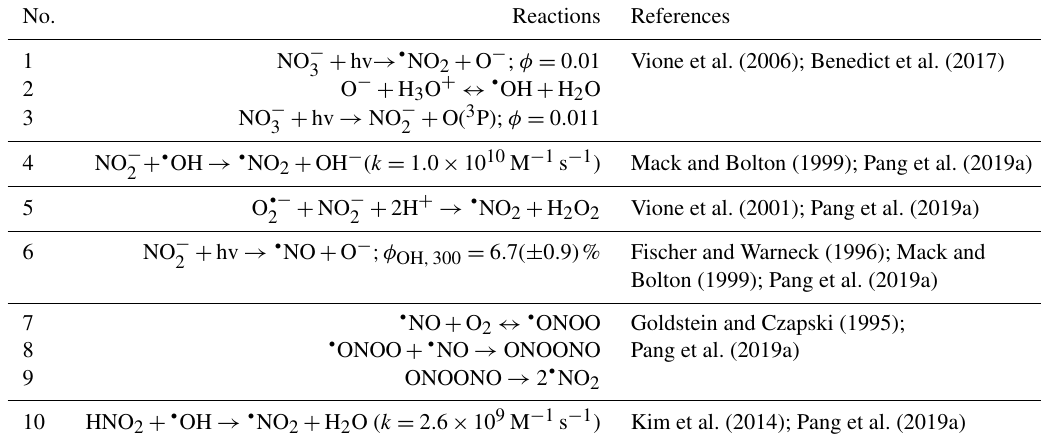
Table 1. List of reactions involving reactive species relevant to this study. No.